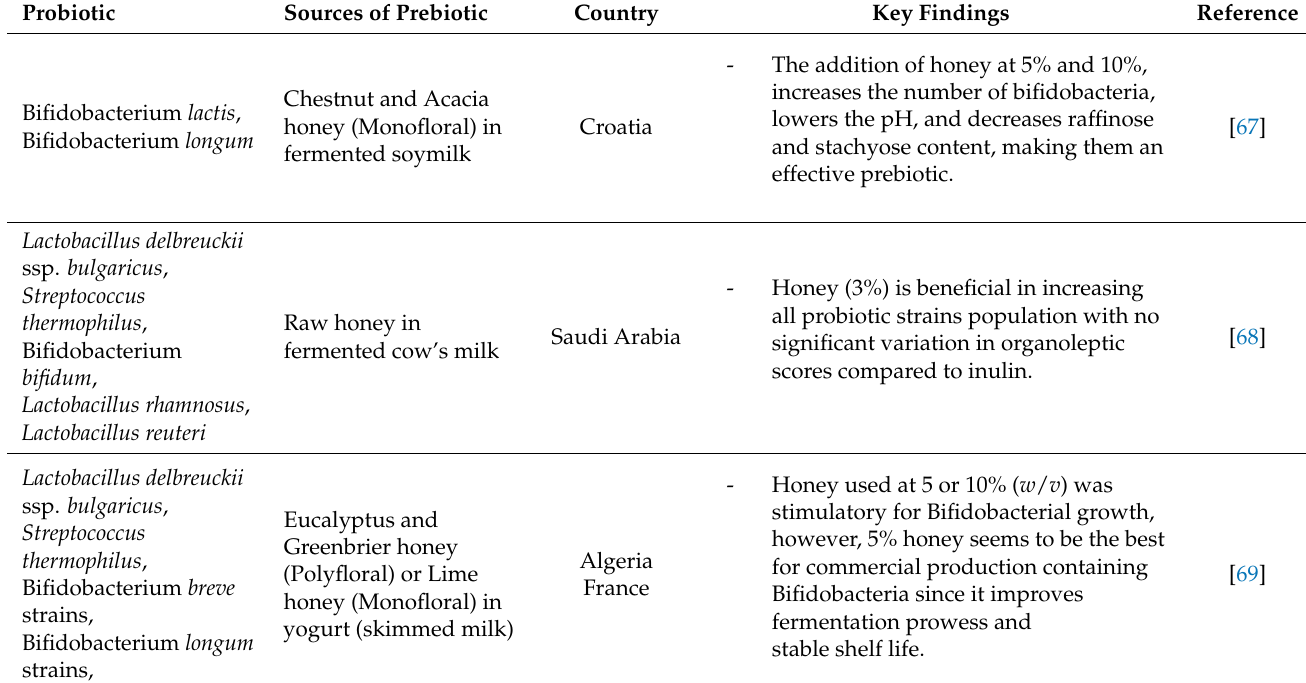
Table 3. The prebiotic potential of honey incorporated into other